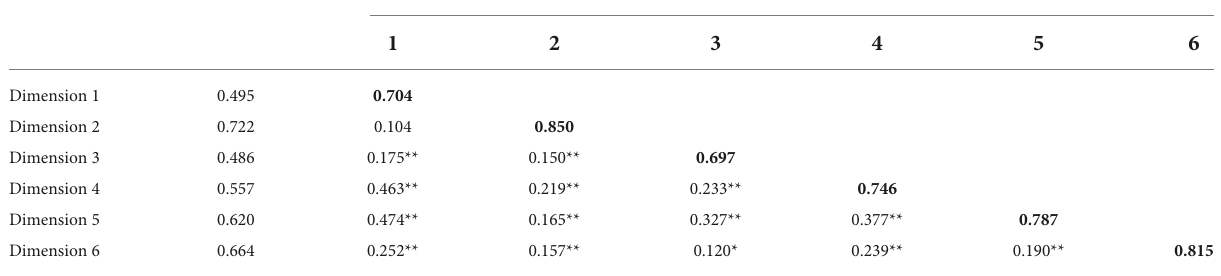
TABLE 3 Correlation coefficient and AVE.